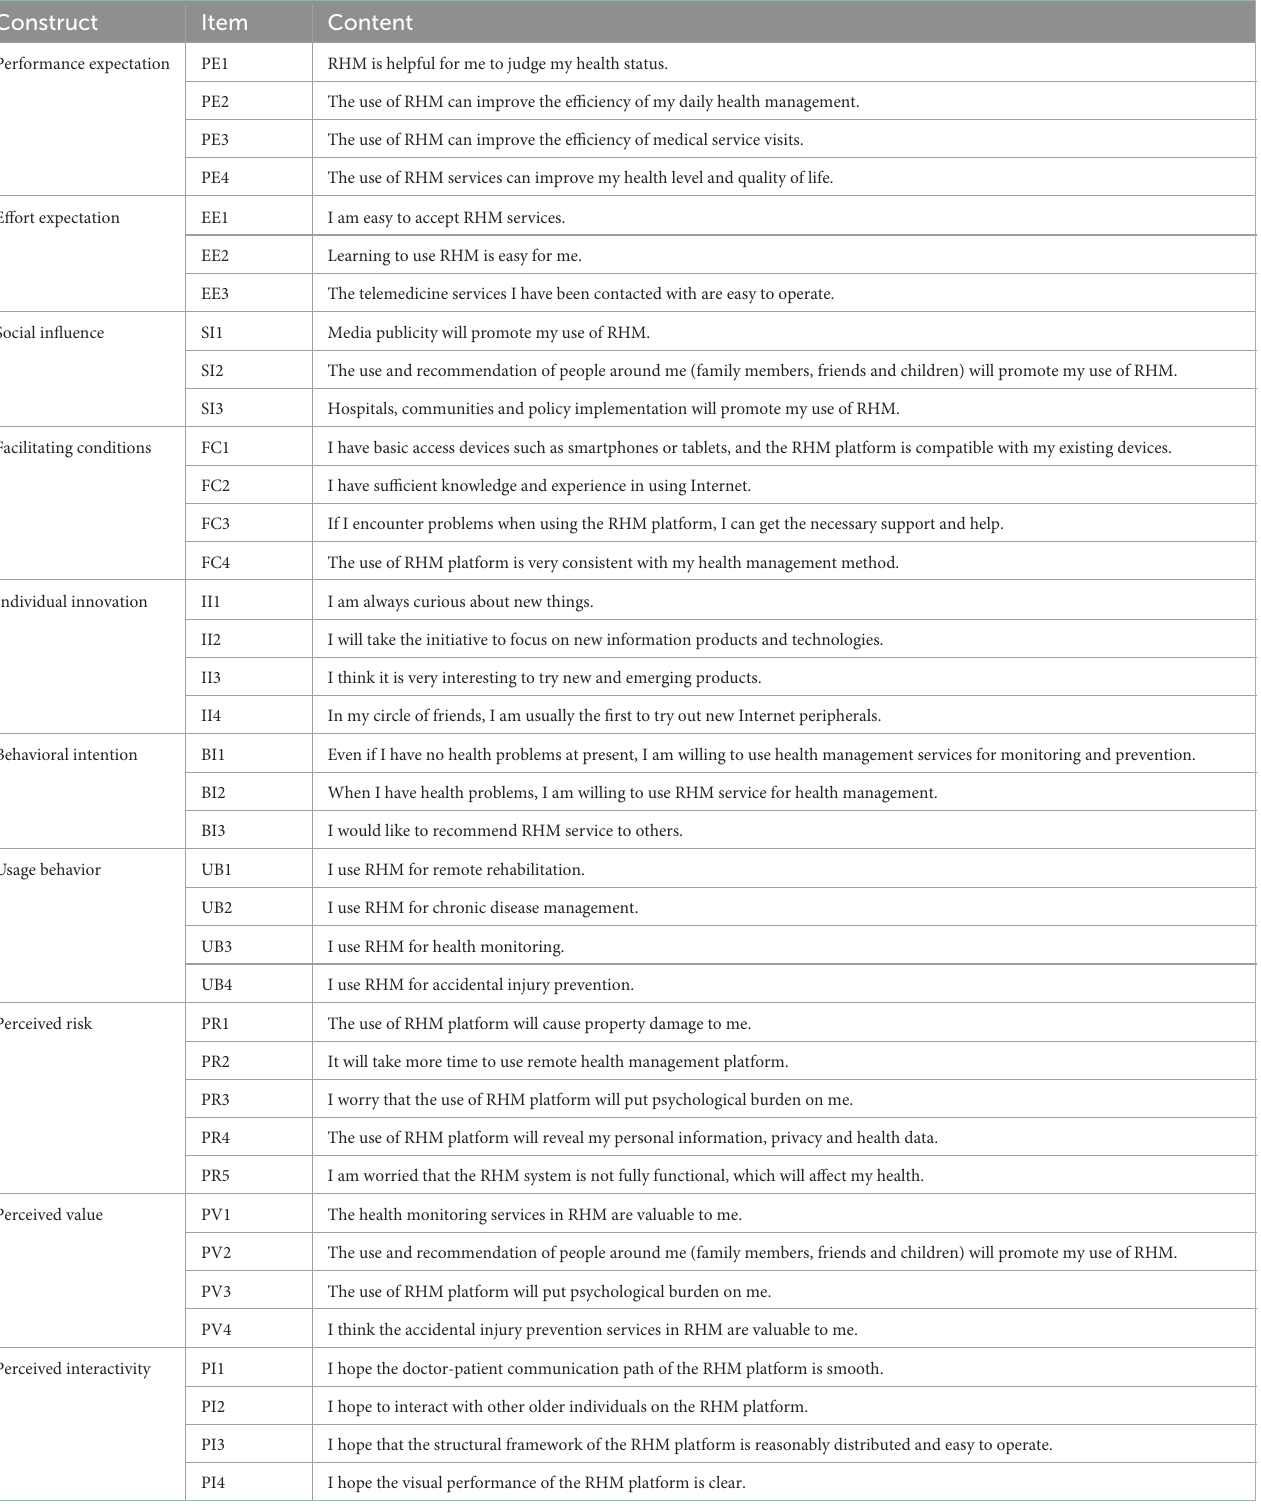
TABLE 1 Measurement items of patient satisfaction research